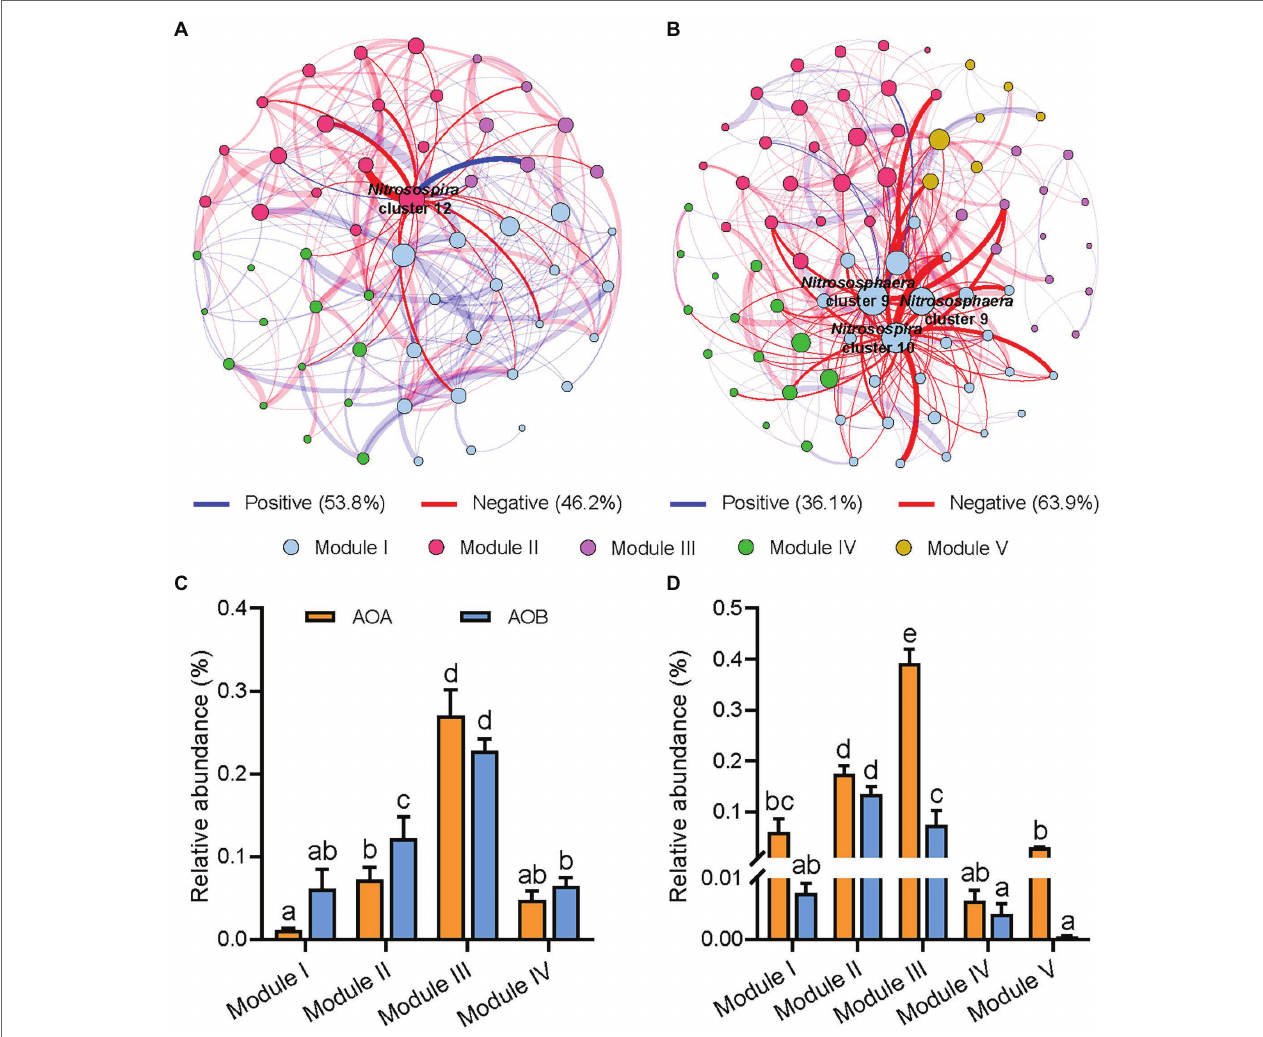
FIGURE 4 | Co-occurrence networks of AOA and AOB populations based on treatments without (OM − ; A , CK and N) and with organic material amendments (OM+; B , NS, NSM, and NB). Relative abundances of AOA and AOB in OM − (C) and OM+ (D) of network’s module eigengenes. The modules I − V represent the five clusters of closely interconnected nodes. Each node represents an OTU and its size is proportional to the number of connections (degree). The thickness of each connection between two nodes (edge) is proportional to the value of Spearman’s correlation coefficients. Blue and red edges indicate positive and negative correlations, respectively. Different lowercase letters indicate significant differences based on Tukey’s HSD test ( p <